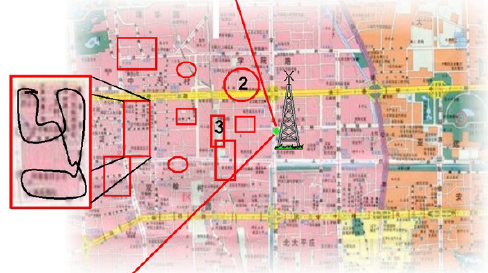
Figure 10: Defined measurement areas within RBS cell coverage.